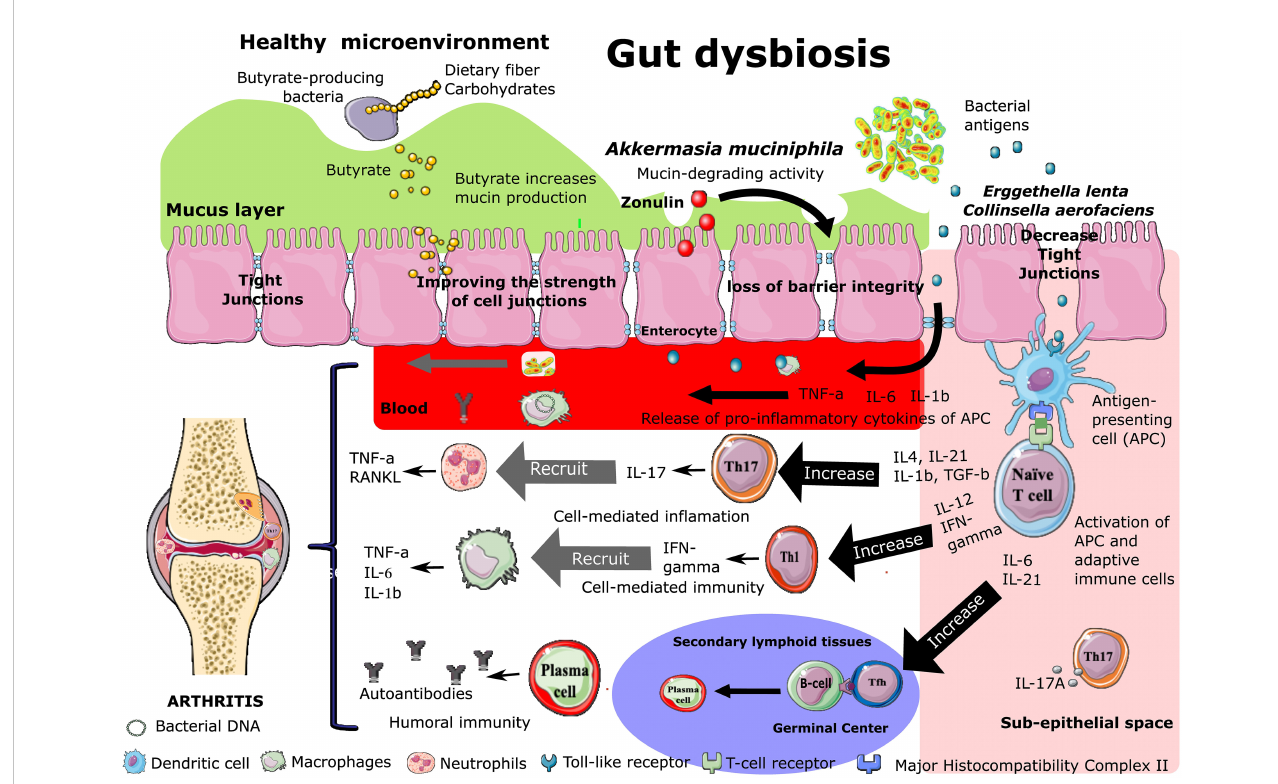
FIGURE 2 Effect of intestinal dysbiosis on intestinal permeability and B and T cell polarization during the development of rheumatoid arthritis. Increased Zonulin secretion is followed by increased intestinal permeability ( “ leaky gut ” ) associated with the disassembly of ZO-1 protein from the tight junction complex. Bacteria or their components are transported to the joints via secondary lymphoid organs or the bloodstream. After encountering the microbiota-derivated antigen presented by antigen-presenting cells (APCs), naive CD4+ T cells differentiate into various subsets, including at least Th1, Th17, and Tfh